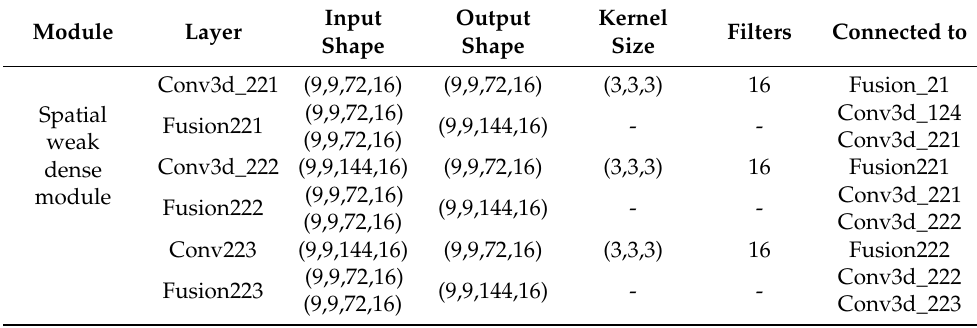
Table 4. The implementation details of the spatial weak dense feature extraction